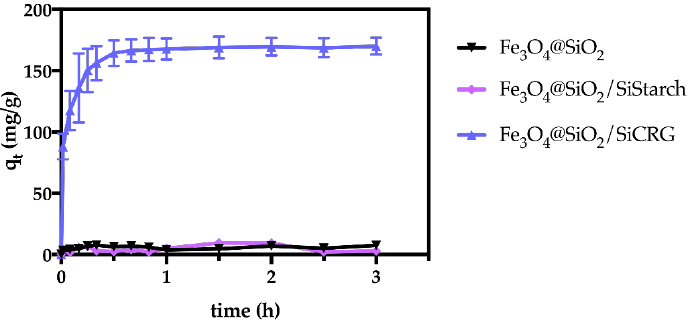
Figure 4. The performance of the bio-hybrids for the removal of paraquat (90 μg/mL) from water at pH 7.3, 25 °C.